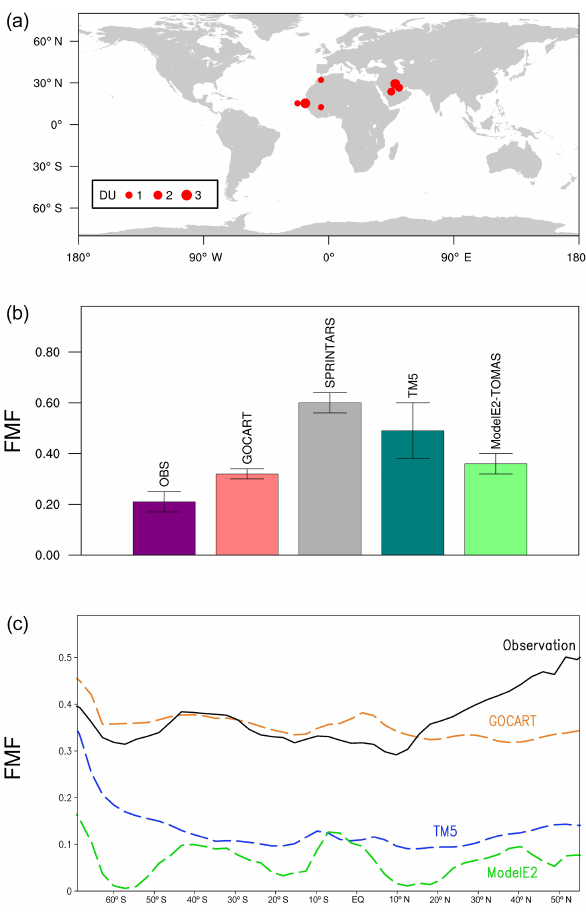
Figure 4. Comparison of simulated and observed fine-mode frac- tion (FMF) at 550nm. (a) Chosen dust-dominated (DU: red dots) AERONET sites. The dot size is proportional to the number of AERONET data from decadal means (2001–2010) for each calen- dar month. (b) Simulated and observed FMF averaged over the cho- sen dust-dominated sites. FMF averages are made by the average AOD and fAOD. The uncertainty represents ± 1.0 standard devia- tion resulting from variation over the sites. FMFs here include the contribution from non-dust particles. (c) Sea salt AOD FMF along the 180th meridian (180 ◦ longitude), using annual average AODs. For observation, total FMF (instead of sea salt AOD FMF) is dis-